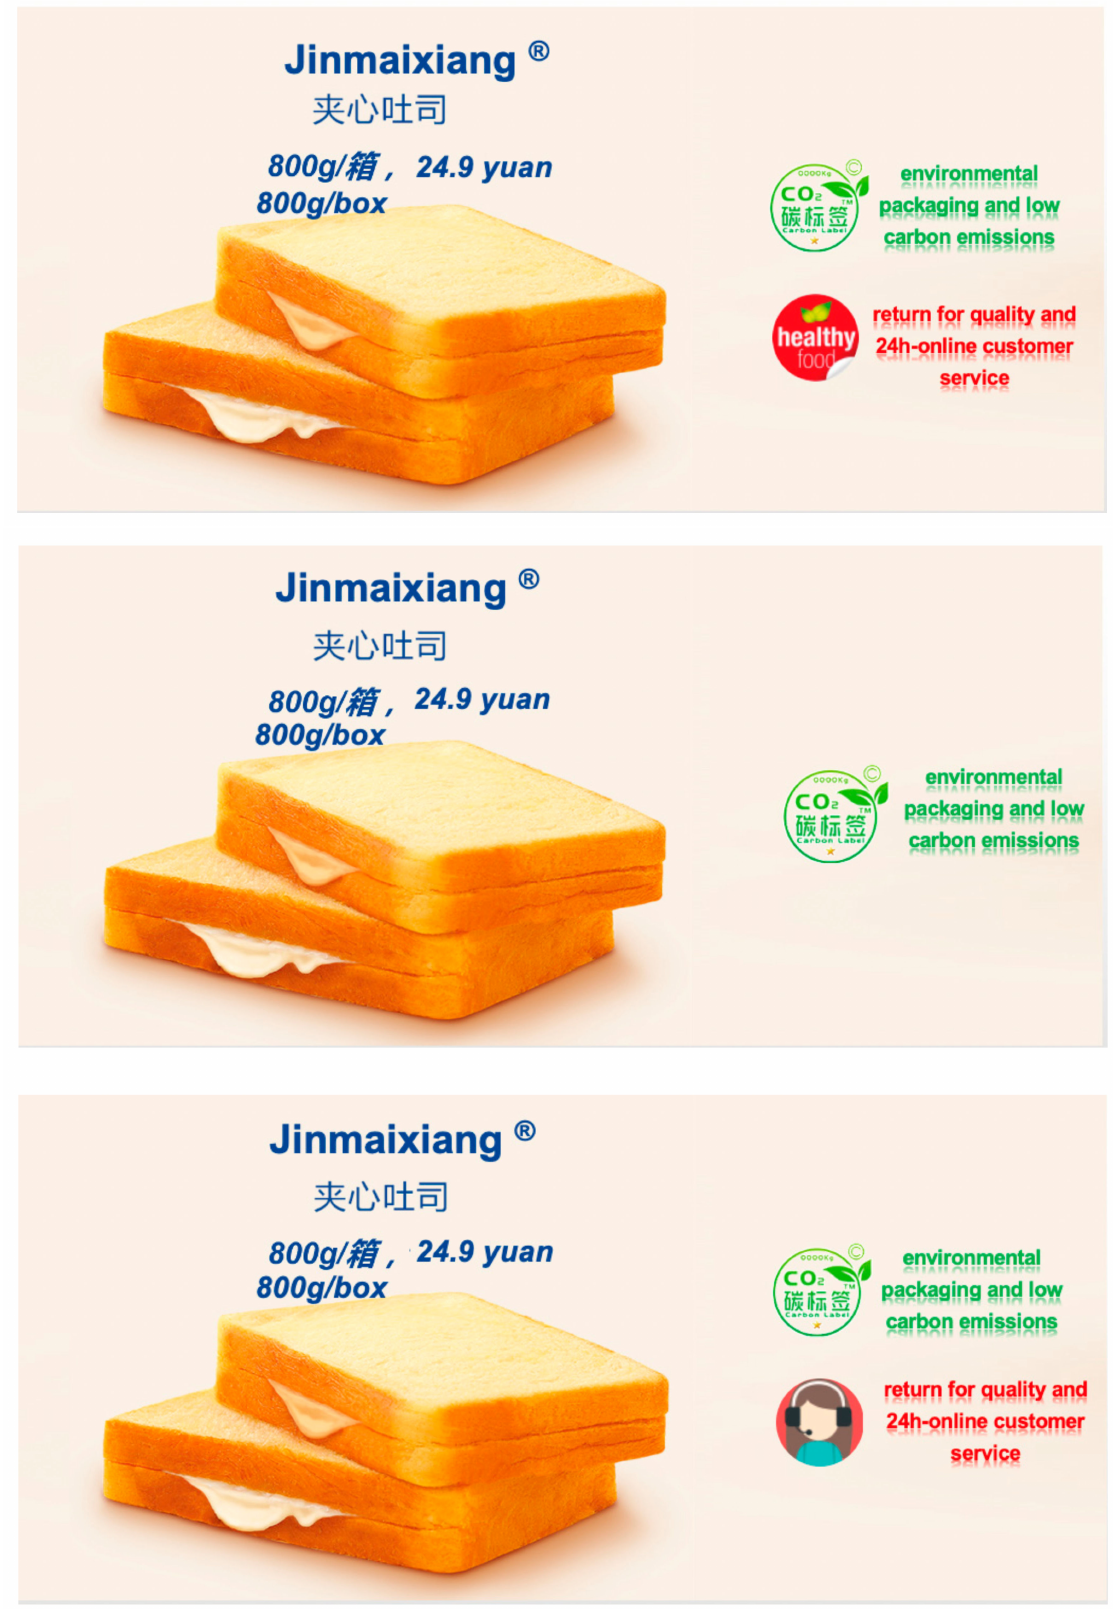
Figure 9. Labels in study